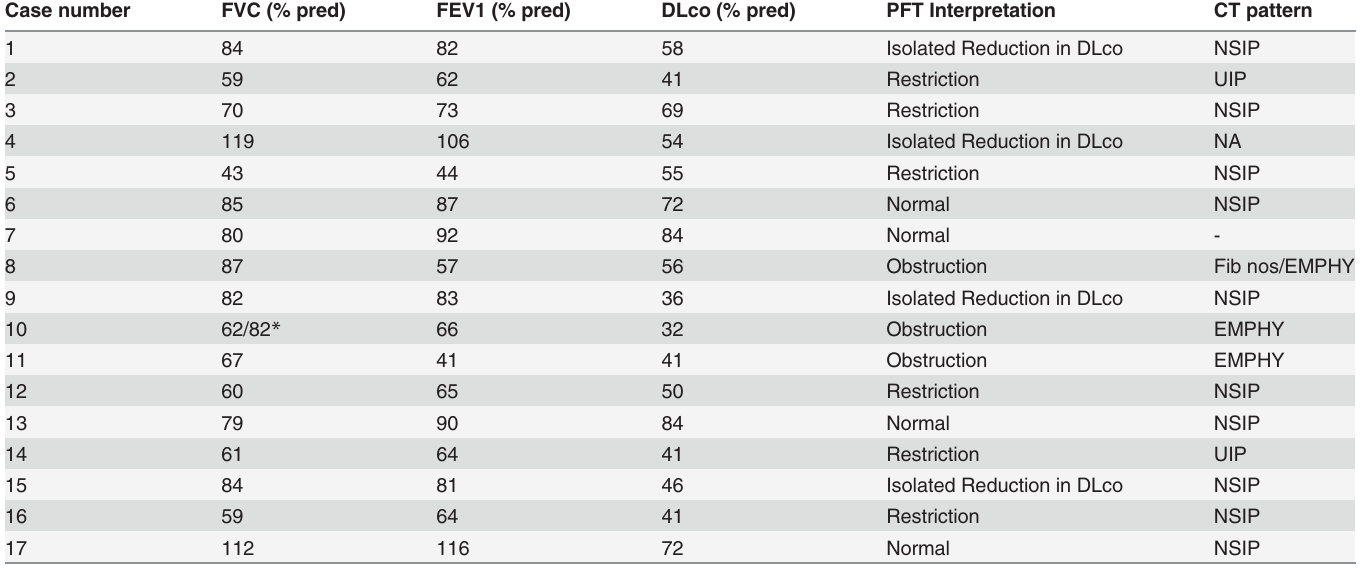
Table 2. Pulmonary function testing and Computed Tomography fi